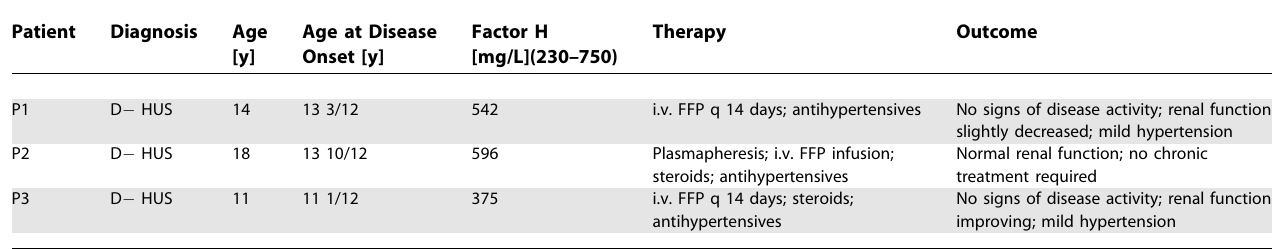
Table 2. Profile of Three Patients Deficient in CFHR1 and